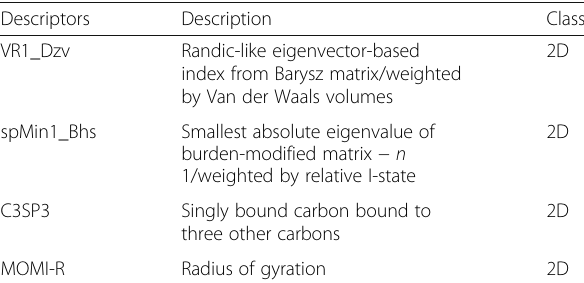
Table 6 Definition of descriptors (model parameters) and their classes for model 4